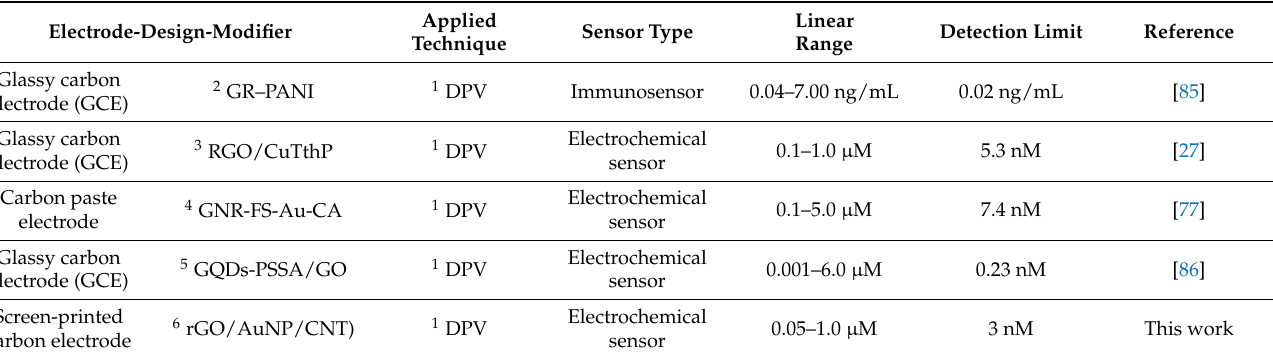
Figure 8. ( A ) DPVs of RGO-AuNPs/CNT/SPEs with different concentrations of E2 (0.05–1 µM) in B-R buffer (pH 5). Automatic baseline correction was carried out based on the report of Górski et al. [84]. ( B ) The oxidation peak current plot against the estradiol concentration, with y = 0.583x and + 0.0343 R 2 = 0.9982. Error bar: standard deviation for n = 3. Table 1. Literature report on electrochemical sensors for estradiol detection.